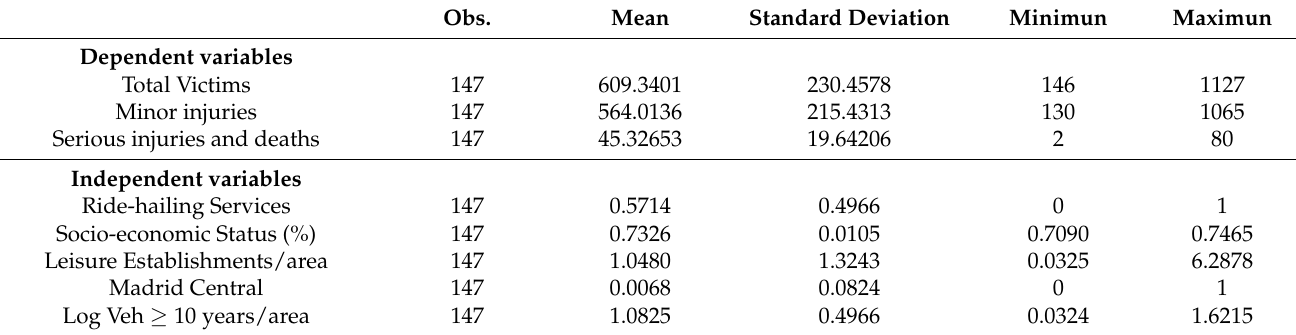
Table 3. Descriptive statistics. Source: own research. Obs.